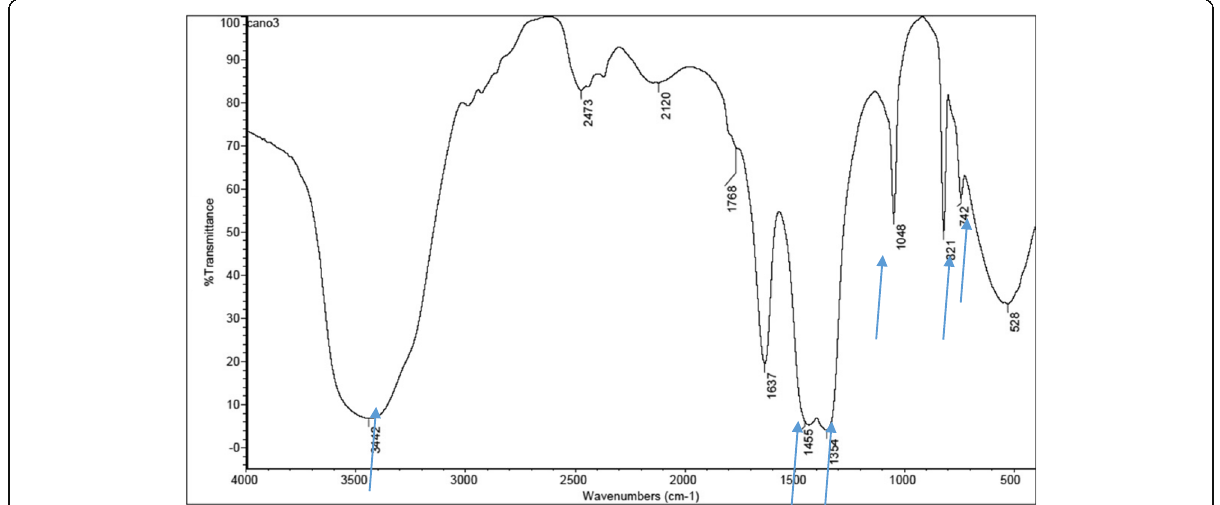
Fig. 2 IR spectra of Ca(NO 3 ) 2 ·4 H 2 O powder prepared from a natural source